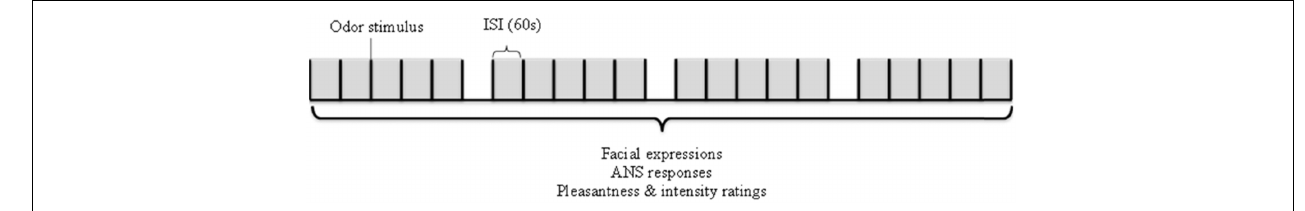
FIGURE 1 | Schematical representation of the experimental procedure followed during one experimental session.